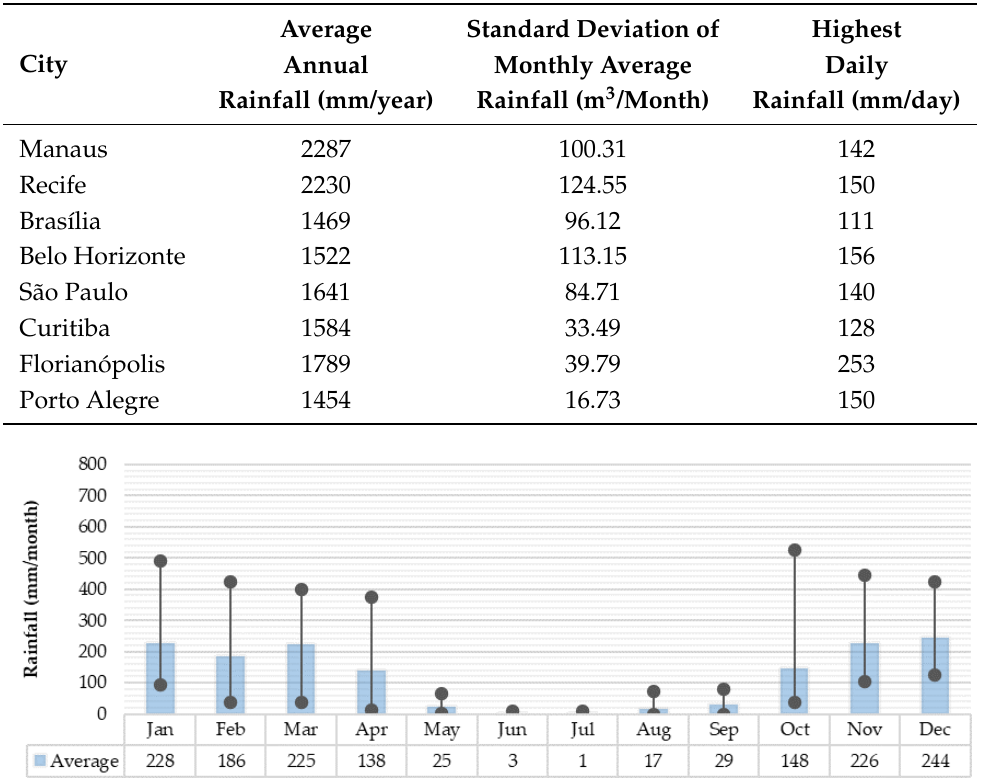
Table 4. Rainfall data in each city over 2003–2017.